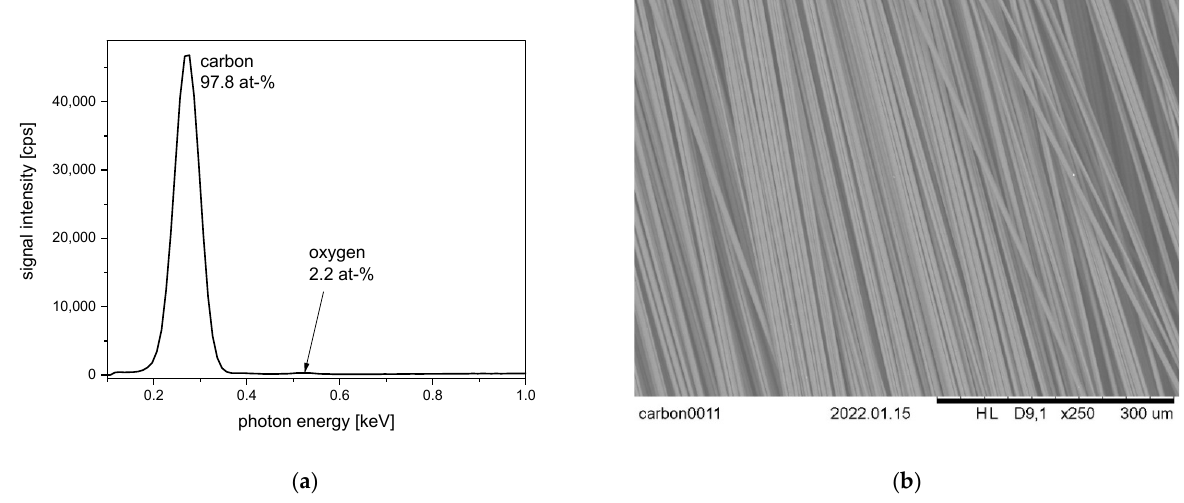
Figure 31. Carbon fibers from roving (Sigrafil C)—( a ) EDS spectrum; ( b ) SEM image.